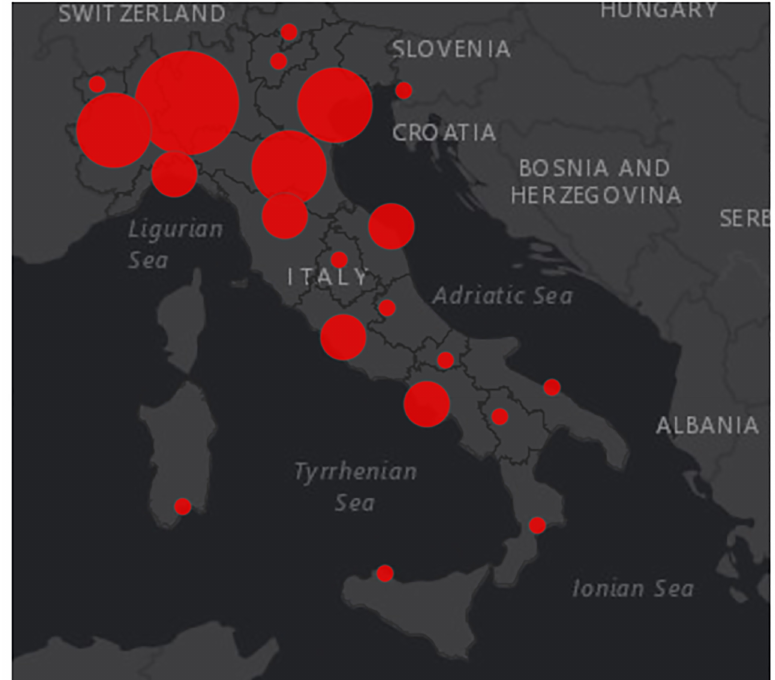
Figure 3 - Distribution of COVID-19 cases in Italy